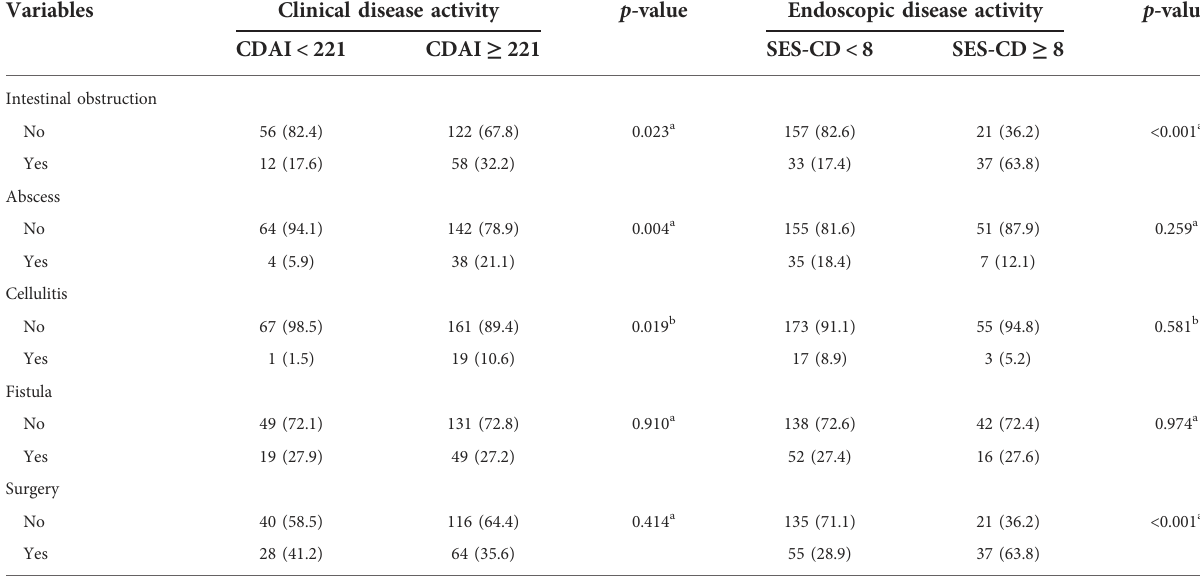
TABLE 3 Analysis of the clinical outcomes in patients with different CDAI and SES-CD scores.